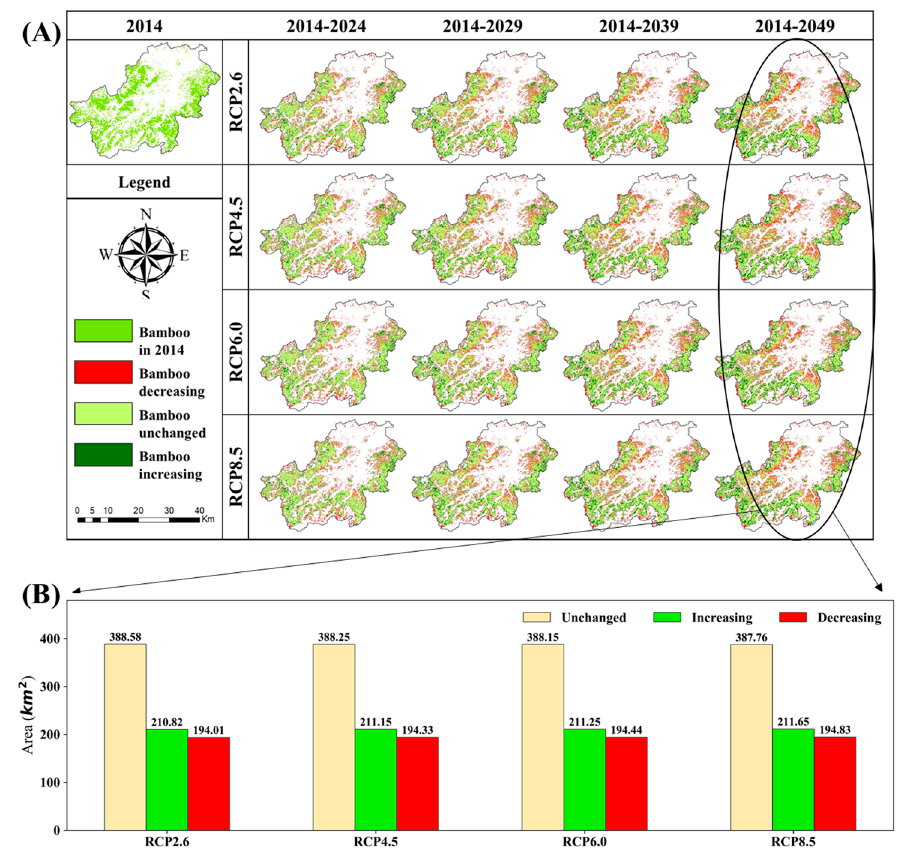
Figure 13. ( A ) Di ff erent simulated results of bamboo forest change in four scenarios in di ff erent periods. Figure 13. ( A ) Different simulated results of bamboo forest change in four scenarios in different ( B ) the statistical area of the bamboo forest change from 2014 to periods. ( B ) the statistical area of the bamboo forest change from 2014 to 2049.